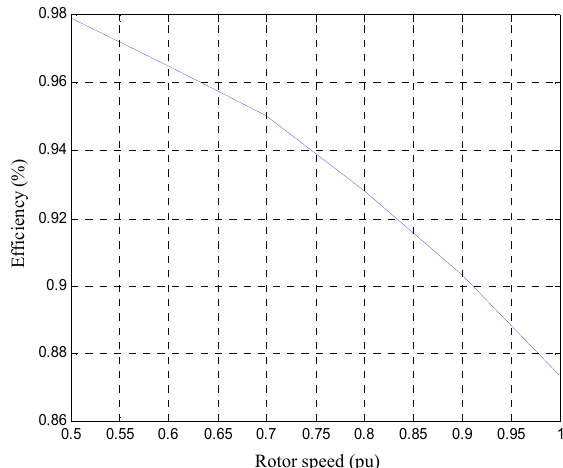
Figure 4. Power versus rotor speed.